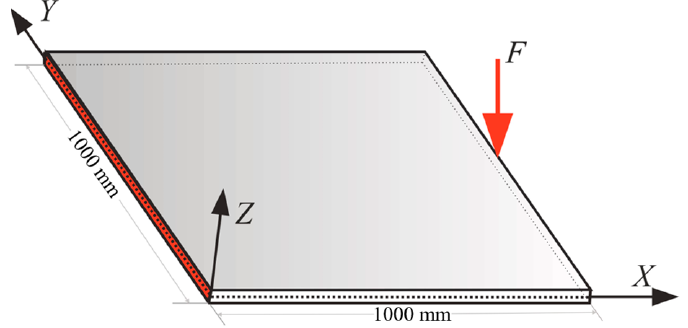
Figure 4. The cantilever plate under transverse loading at the middle of its free edge.